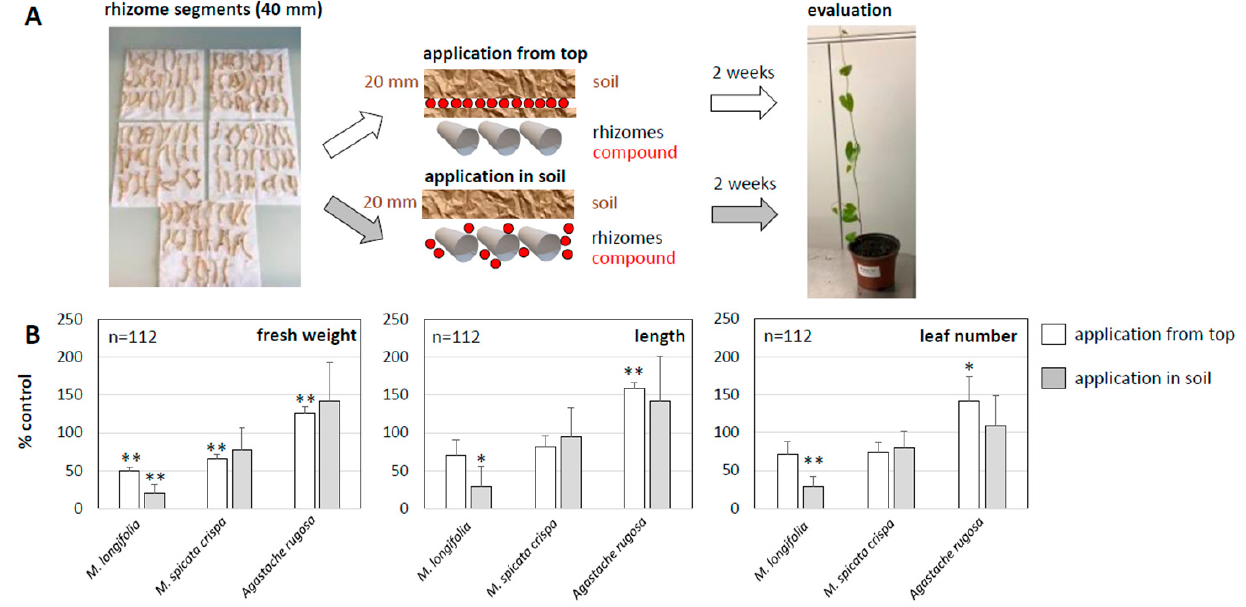
Figure 8. E ff ect from mint oil formulations on the development of regenerating rhizome sections of Convolvulus arvensis. ( A ) Design of the experiment: 50 µL of essential oils from three di ff erent mints were formulated in 2 g of a slow-release carrier corresponding to 2.5% v / v and either placed on top of the rhizomes or worked into the soil where the rhizomes were cultivated. ( B ) Quanti fi cation of the e ff ect after 2 weeks of treatment, measuring shoot fresh weight, shoot length, and number of leaves. Data points represent mean values and SE from two independent experimental series with nine individuals per data point and replication. Signi fi cant di ff erences from the control are indicated by * ( p < 0.05) and ** ( p < 0.01).